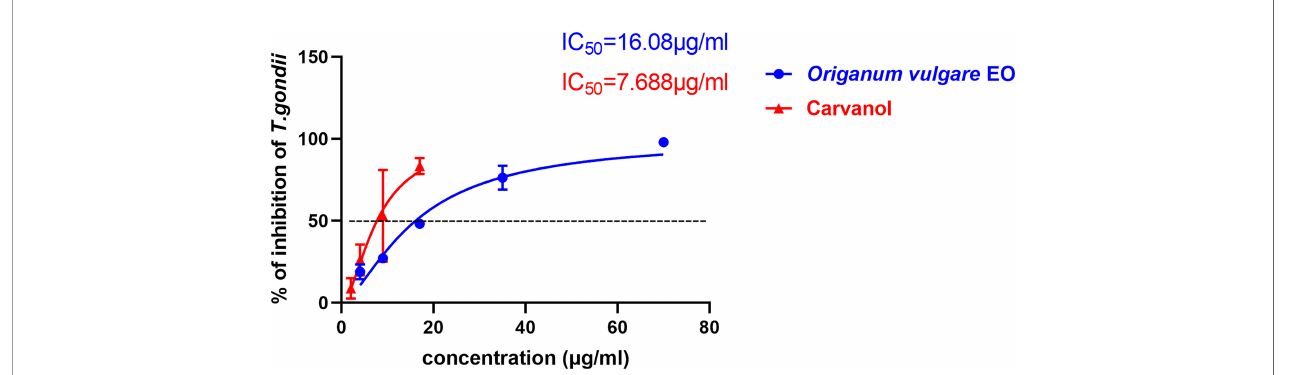
FIGURE 5 | The 50% inhibition concentrations (CC 50 ) of Ov EO and Ca. Inhibition of Ov EO and Ca to T. gondii . Different concentrations of Ov EO and Ca treated infected HFF cells for 32 h, the growth of GFP-RH was observed and photographed under a fl uorescence microscope. Growth of GFP-RH was calculated using Image-Pro-Express. All data are presented as with error bars and the experiments were performed